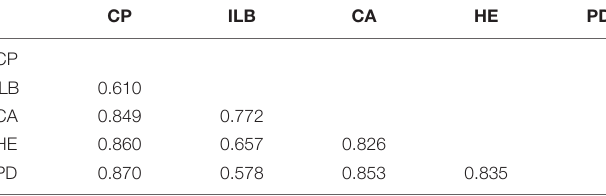
TABLE 4 | Discriminant validity—HTMT.